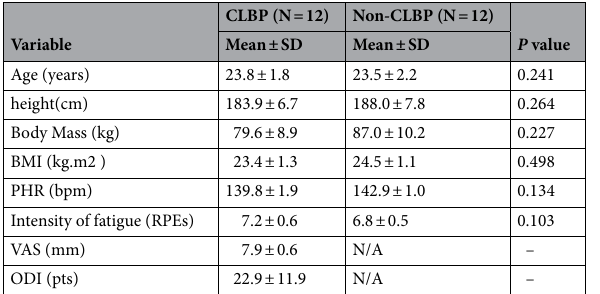
Table 1. Participant demographics. BMI Body Mass Index, PHR Peak Heart Rate, RPEs Rate of Perceived Exertion scale, VAS Visual Analogue Scale of current pain, ODI Oswestry Disability Index.